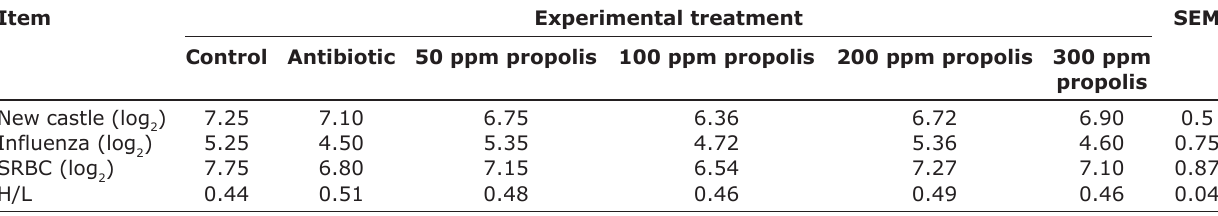
Table-4: Effect of experimental treatments on antibody titers against Newcastle and Influenza viruses at 28 days of age and SRBC at 31 days of age, and H/L and albumin to globulin ratios at 42 days of age. Item Experimental treatment SEM